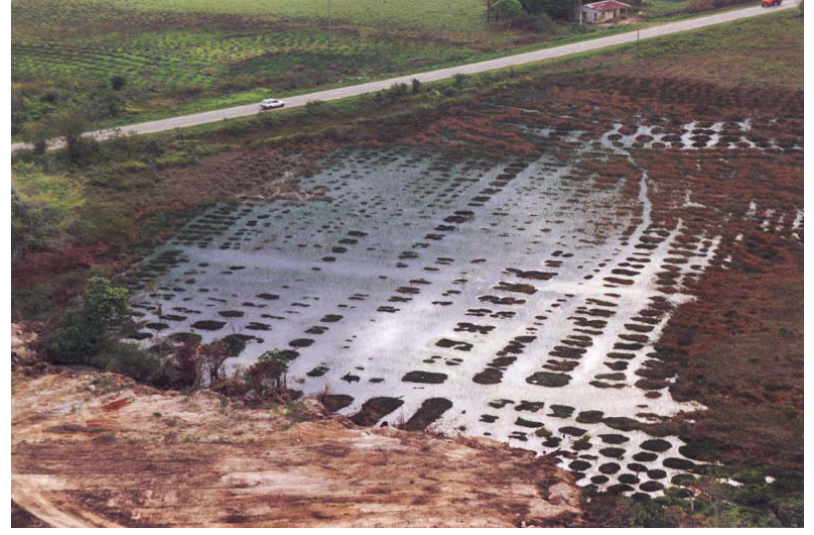
Figure 7. Large raised